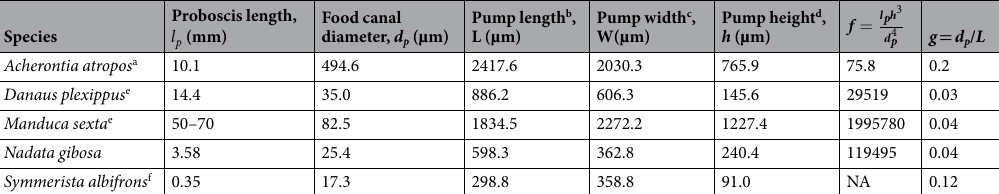
Table 1. Characteristics of the proboscis and sucking pump of selected Lepidoptera. f is a dimensionless factor that specifies the mechanism of energy dissipation. a Data from Fig. 2D,E in ref. 41 were analyzed in Image J. b Longest distance within the chamber, parallel to the floor of the pump. c Greatest width within the chamber, perpendicular to the length of the pump chamber. d Greatest height, dorsal to ventral, along the mid-sagittal plane and perpendicular to the length of the pump. e Proboscis lengths for D . plexippus and M . sexta and food canal diameter for D . plexippus were taken from the literature 25, 66, 71 . f Diameter of the food canal of a single galea, measured from dorsum to venter. The two galeae do not meet (Fig. 2A); therefore, a single food canal is not formed; the food canal was assumed to be circular.